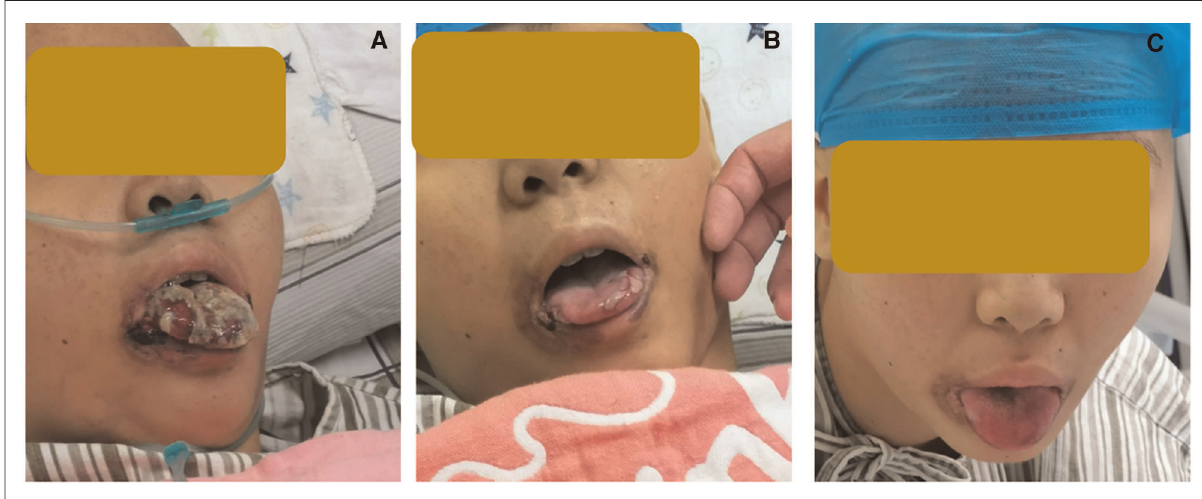
FIGURE 1 Change of oral fungal infections ( A ) on day − 7 before HSCT, ( B ) on day +30 after HSCT, and ( C ) on day +55 after